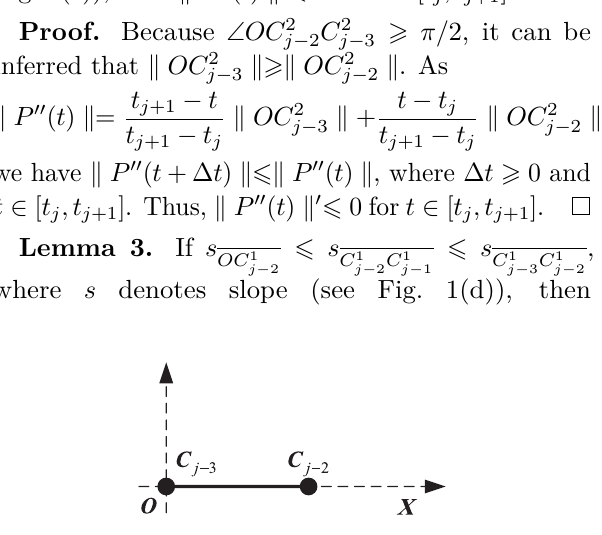
Fig. 2 Local coordinate system for a curve